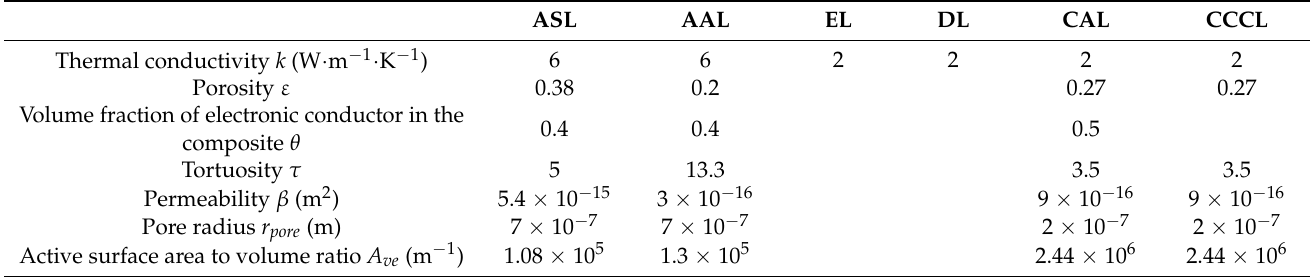
Table 5. Properties for different components of the cell [1].